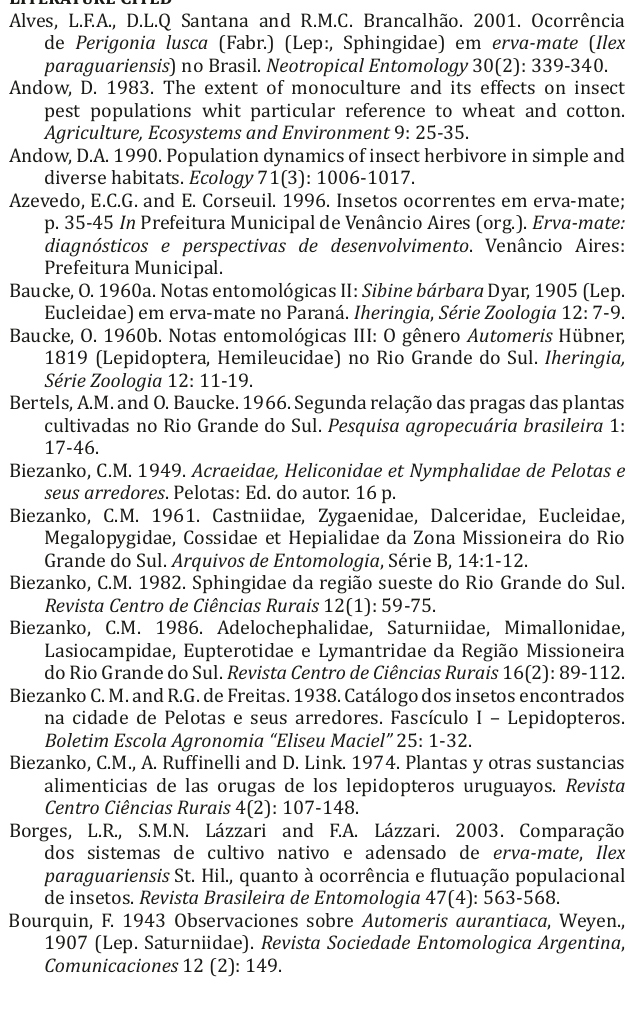
Number of Lepidoptera taxa per family occurring on